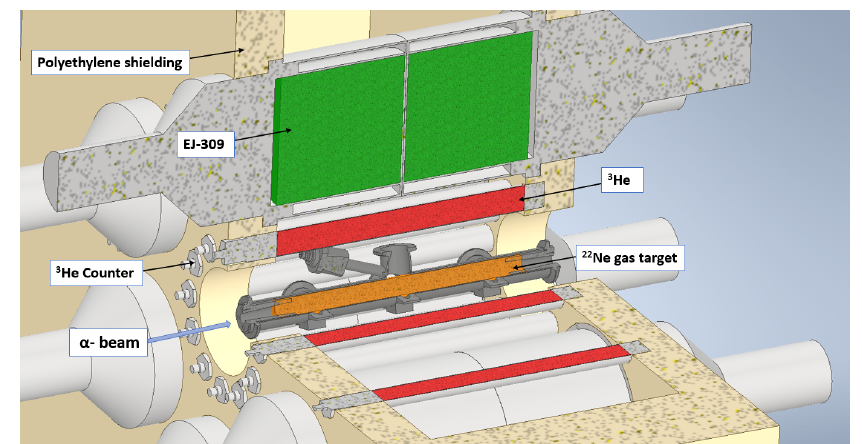
Figure 3. Cut-view of the SHADES detectors array and gas target